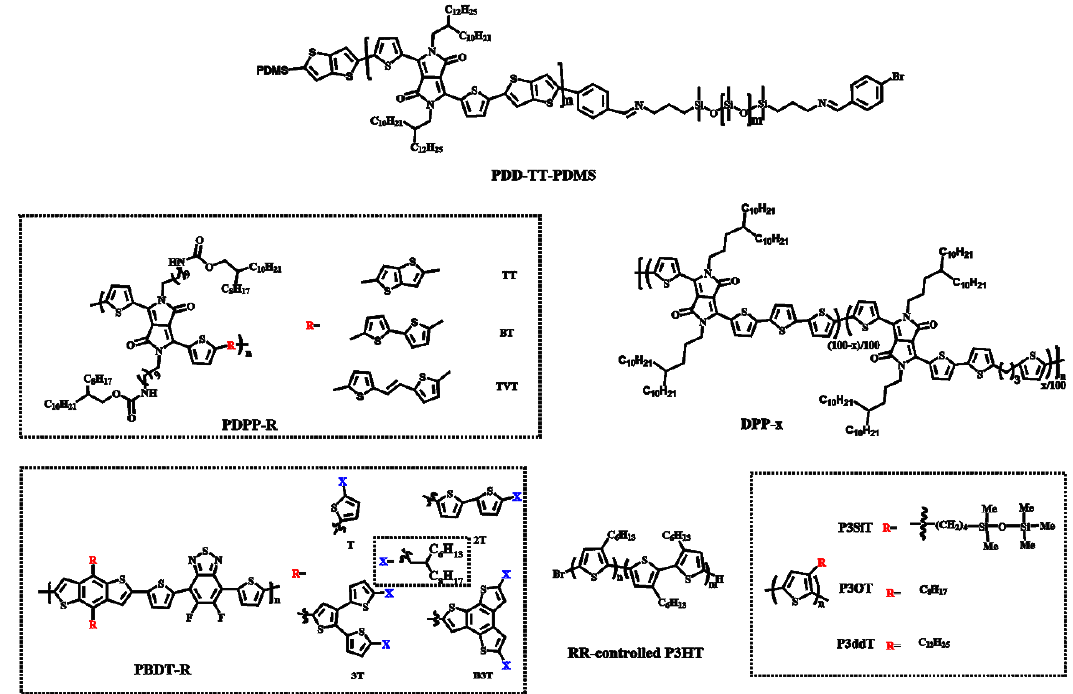
Figure 3. Chemical structures of IEOSs obtained by coupling